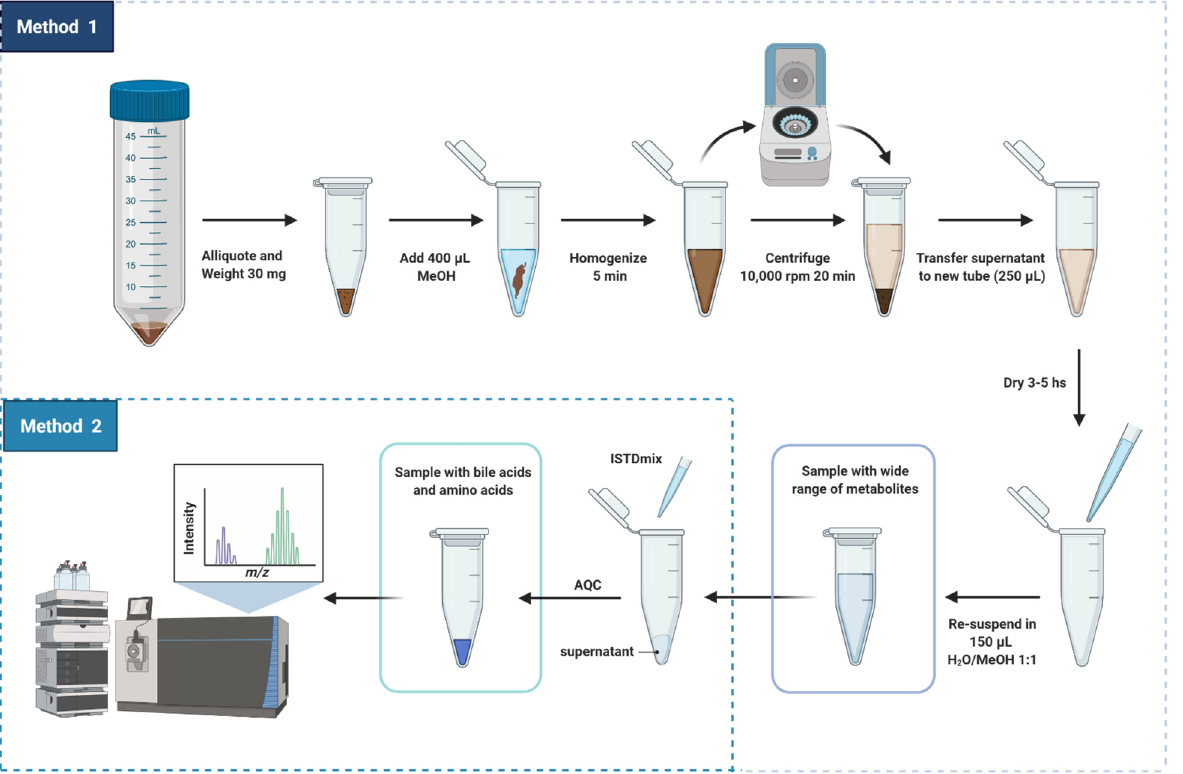
Figure 1. Scheme of sample preparation of fecal samples for targeted analysis of metabolites related to the gut-liver axis. Created with biorender.